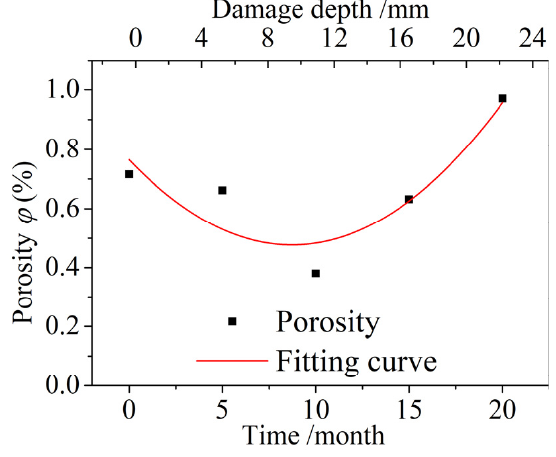
Figure 8. Variation in the porosity after different dry and wet cycle inspection periods.